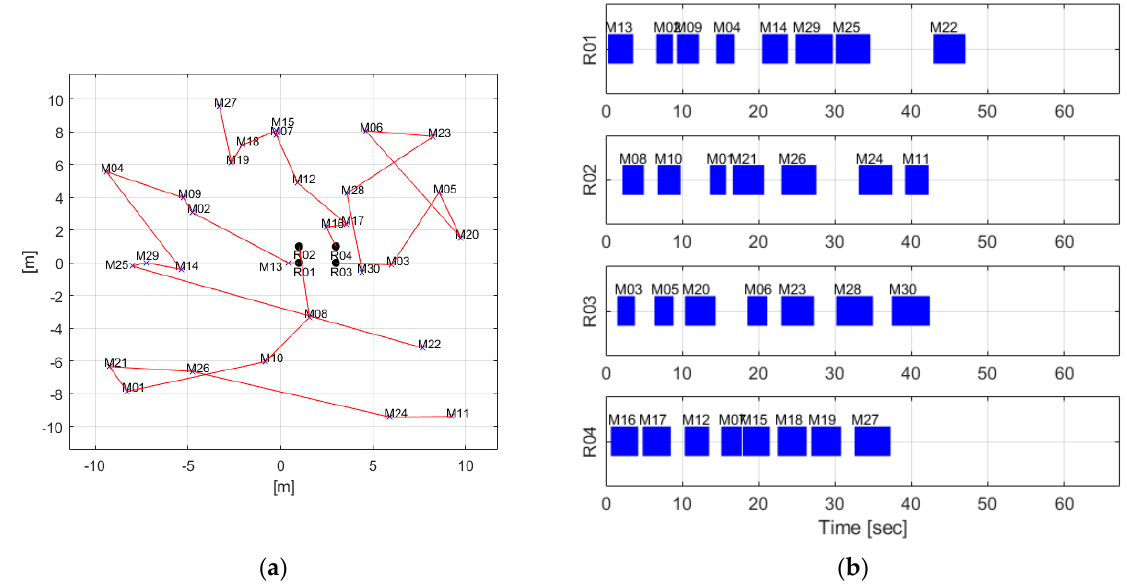
Figure 5. The results for medium case using TACTAR: ( a ) 2D situation map; ( b ) timetable.